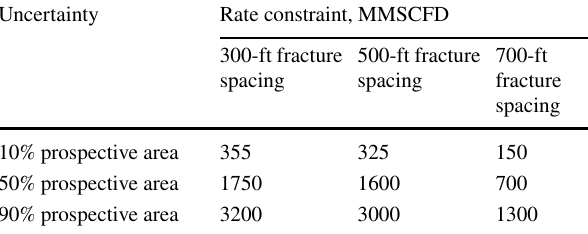
Table 6 Rate constraint for case